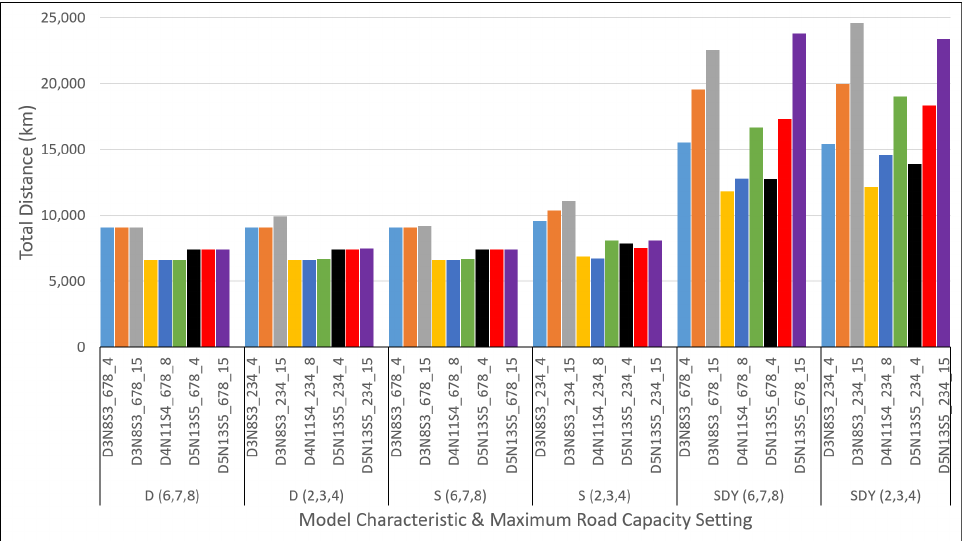
Figure A20. Total Distance Travelled in Online and Offline Computation for all Instances grouped by Model Characteristic and Maximum Road Capacity